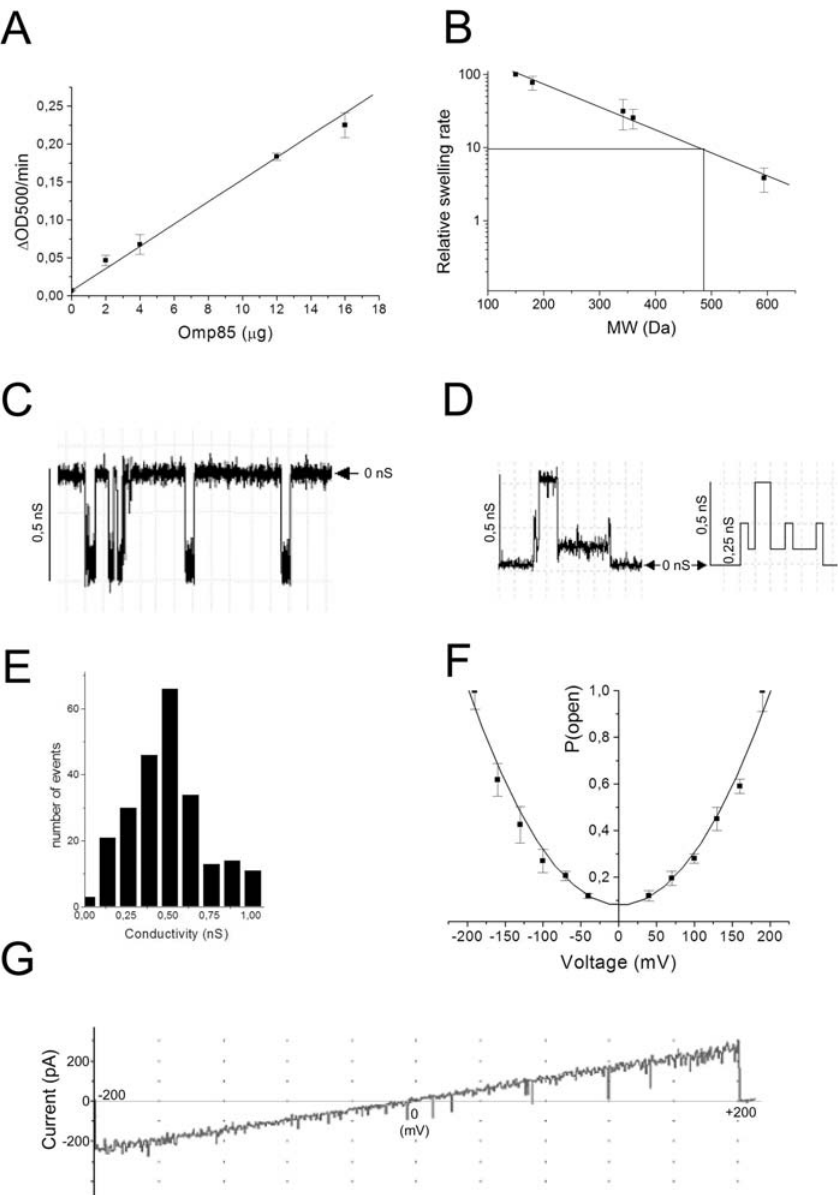
Figure 3. Pore-Forming Activity of Omp85 (A) Swelling rates of proteoliposomes reconstituted with the indicated amount of Omp85 in iso-osmotic solutions of L-arabinose. (B) Relative swelling rates of proteoliposomes containing Omp85 in solutions of sugars with different MW. The sugars used were arabinose (150 Da), glucose (180 Da), saccharose (342 Da), maltose (360 Da), and raffinose (594 Da). The data are shown relative to the swelling in arabinose and are the averages of at least four independent experiments. The indicated swelling rate corresponding to 10% of that in arabinose served to estimate the size of the channel. (C) Recording of Omp85 pores formed in planar lipid bilayers at an applied potential of (cid:1) 150 mV. (D) Current recordings showing sub-conductance states of Omp85 channels and its idealized current trace (right panel). The horizontal arrowhead shows the zero-conductance level. (E) Amplitude histogram of current derived from channel openings at þ 50, þ 100, and þ 150 mV. Results from four experiments were pooled. (F) Voltage dependence of the probability for the Omp85 channel of being in its open state. Data were normalized relative to the maximal mean current at 190 mV. Data points represent averages of two independent bilayers. (G) Voltage-ramp analysis of Omp85 channels from 0 to 200 mV and from 0 to (cid:1) 200 mV. In the experiment shown, eight 0.12-nS channels were present in the bilayer. DOI: